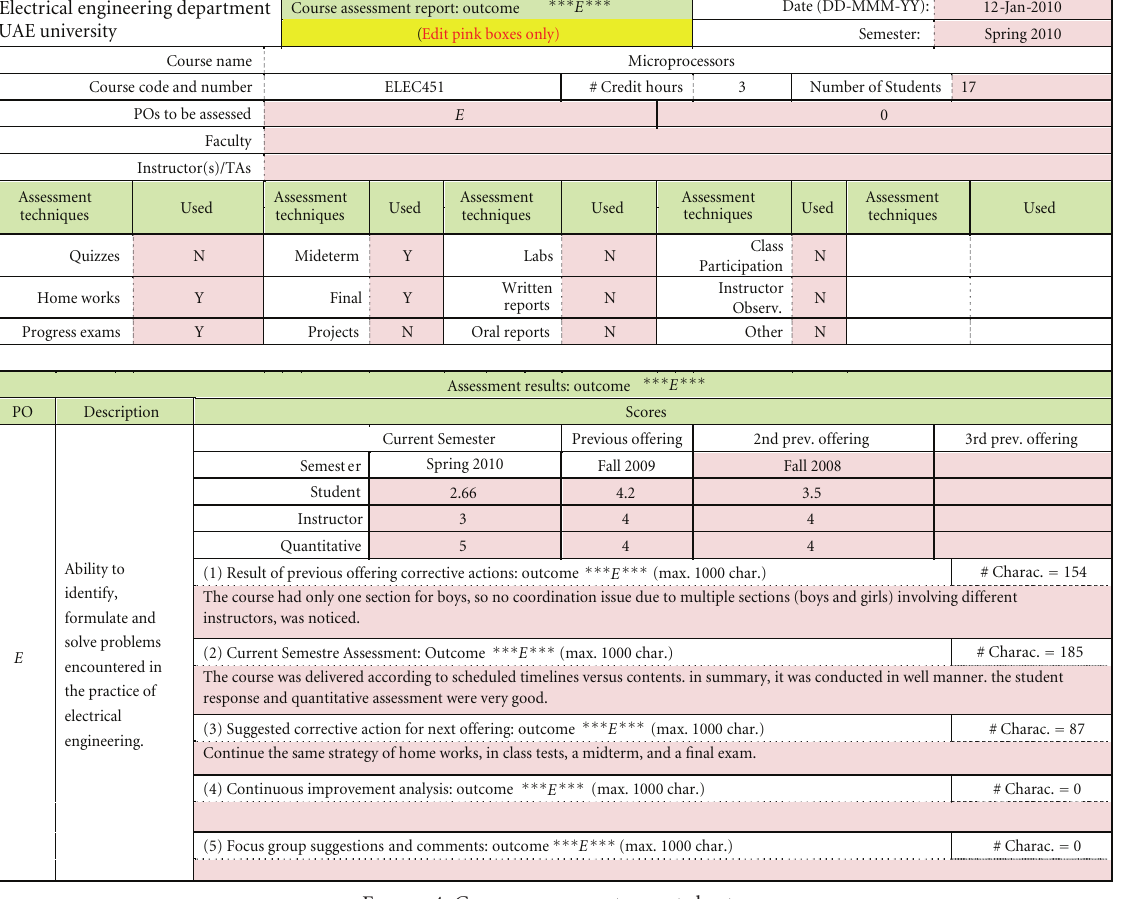
Figure 4: Course assessment report sheet. Table 1: Computer area (basket) courses mapped to program